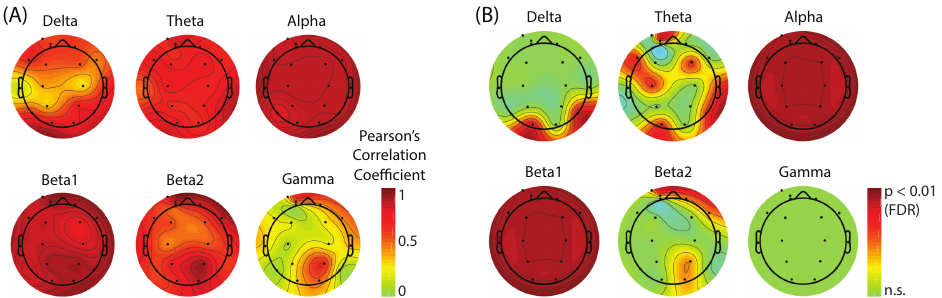
Figure 6. Pearson’s correlation coefficients ( A ) and statistical significance mask with FDR-corrected p -value, p < 0.01 ( B ). The correlation between the ∆ power and the amount of visual delay was tested for all the combination of scalp electrodes and frequency bands, which was corrected using a false discovery rate (18 × 6 × 15 = 1620 tests). Note that alpha and beta1 showed global response to the increase of visual delay. However, the globally saturated result also means poor spatial resolution of the underlying EEG